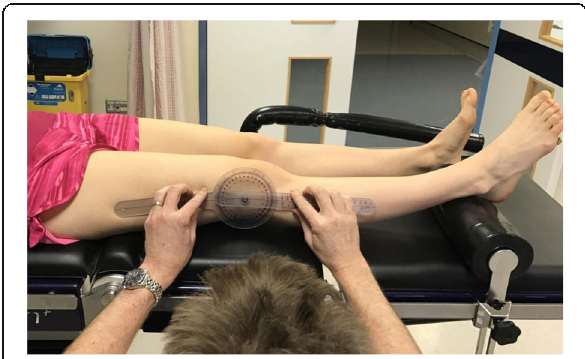
Fig. 3 Technique for measuring full extension (long arm